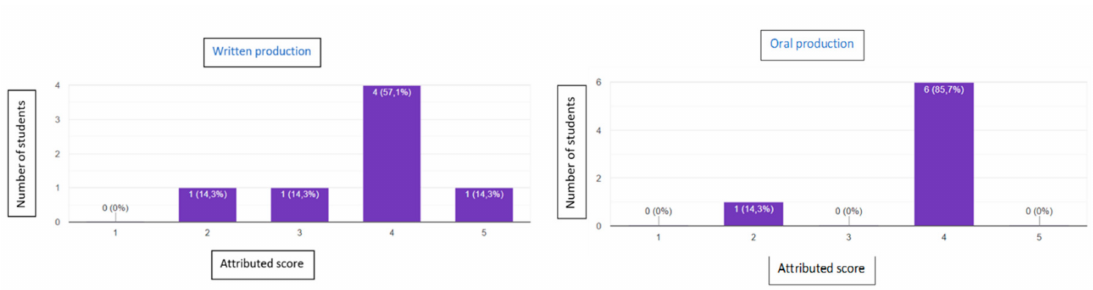
Figure 5. Production competences chart of F3/F6 students.